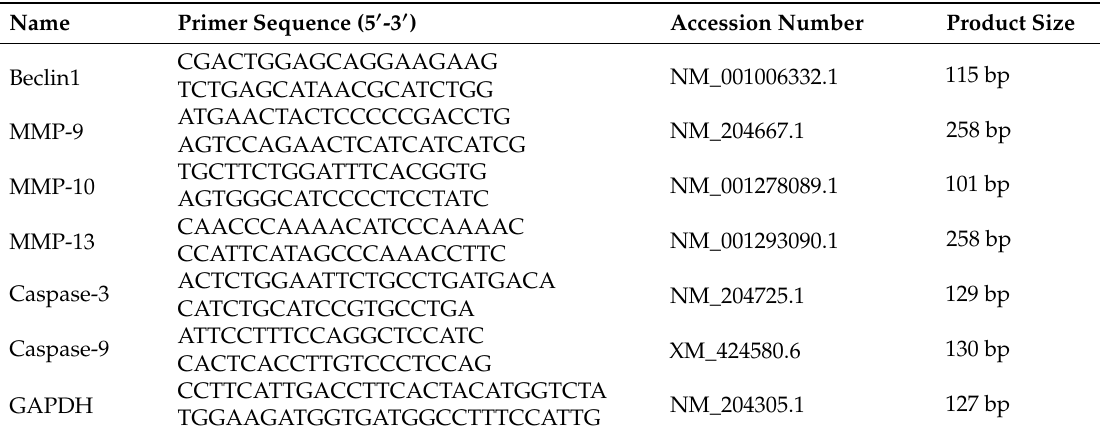
Table 1. Primers uesd for